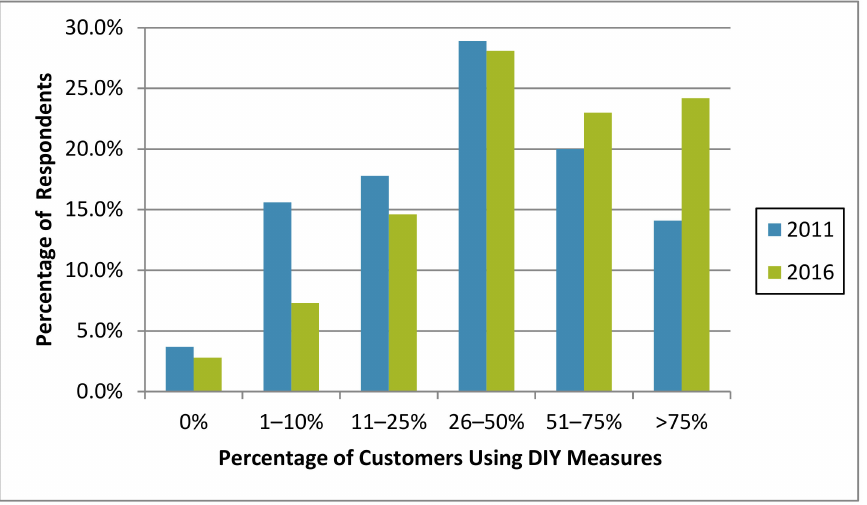
Figure 8. Estimated percentage of customers using DIY measures before calling for a licensed professional in 2011 and